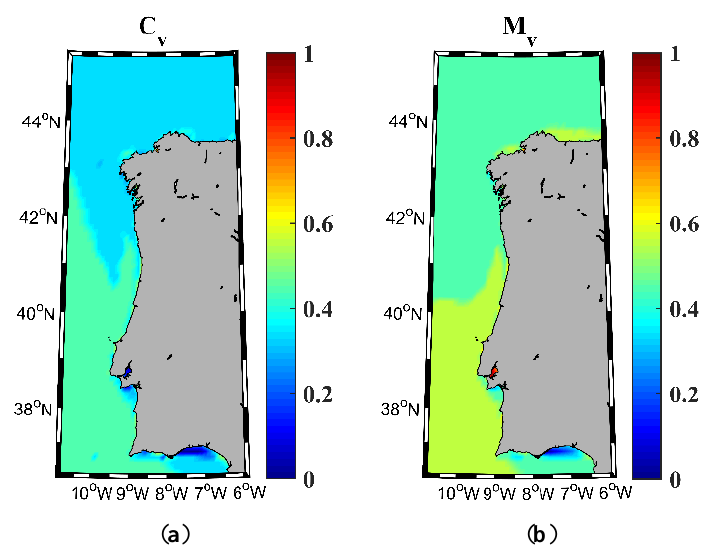
Figure 5. Variability indices for wave energy resource. Variation coefficient ( a ) and monthly variability ( b ) in the NW Iberian Peninsula for the near future (2026–2045). ( b ) in the NW Iberian Peninsula for the near future (2026–2045).